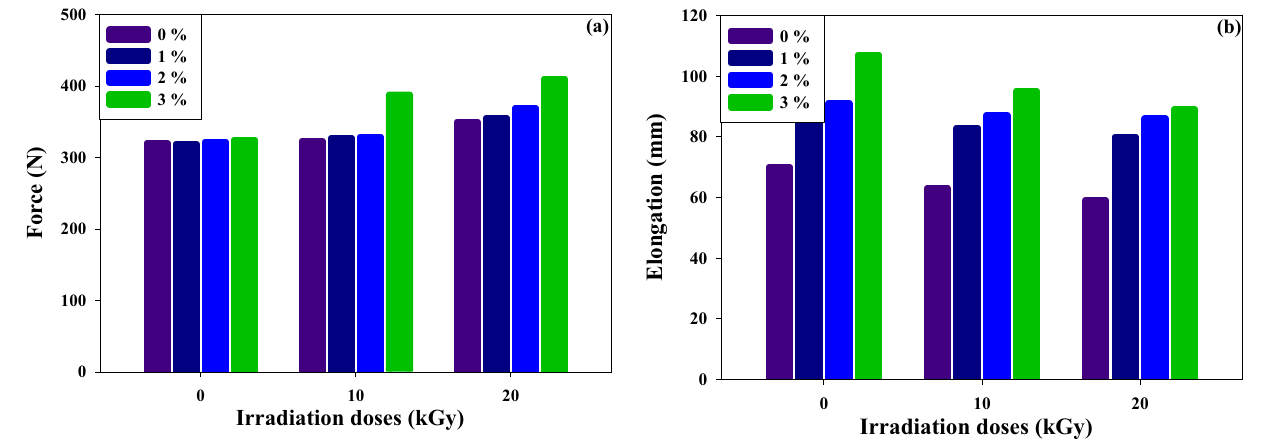
Figure 2. The effect of SBR content and irradiation doses on the mechanical properties of (PVC/LLDPE)ZnO